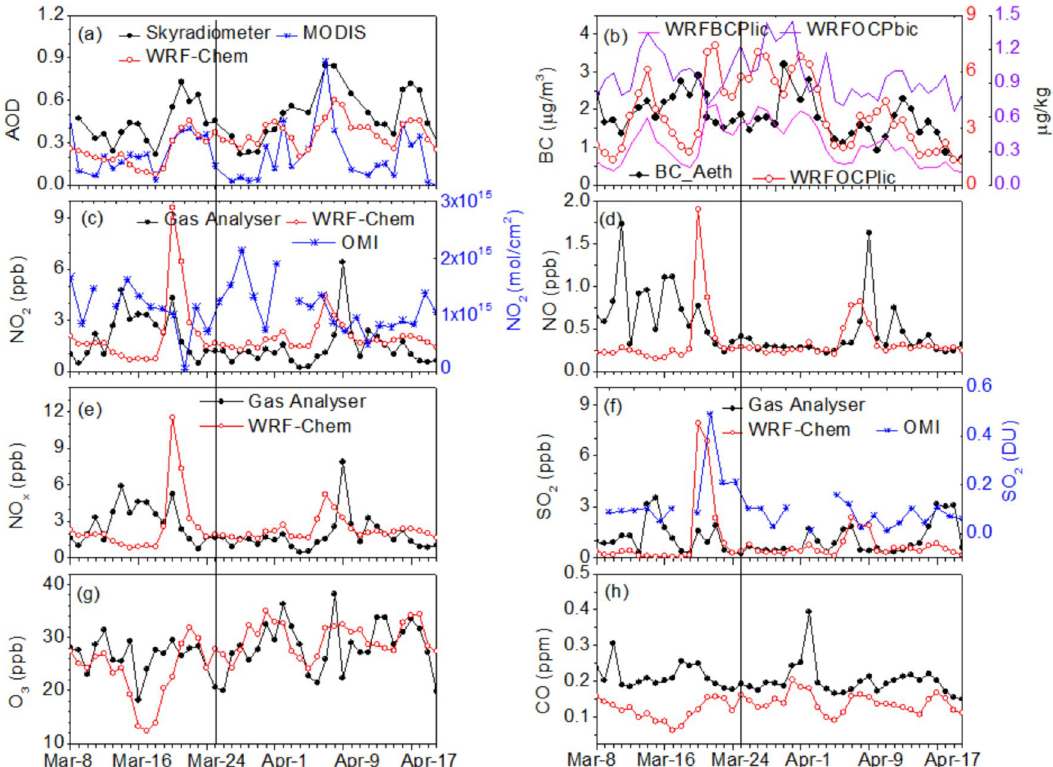
Figure 1. Time series for ( a ) AOD, ( b ) BC, ( c ) NO 2 , ( d ) NO, ( e ) NO x , ( f ) SO 2 , ( g ) O 3 , and ( h ) CO obtained from WRF-Chem model simulations for March 8 to April 20, 2020 over the Gadanki region. Trace gases obtained from a gas analyser at Gadanki are superimposed on the respective panels ( c – h ). Skyradiometer AOD and Aethalometer BC are also superimposed in ( a ) and ( b ), respectively. Hydrophilic and hydrophobic BC and OC as simulated by WRF-Chem are also shown in ( a ). MODIS AOD is superimposed in ( a ). NO 2 and SO 2 from OMI are superimposed in ( c ) and ( f ), respectively. Note that model simulated O 3 and CO are doubled and halved, respectively. WRF-Chem simulated outputs are represented by red lines, ground-based observations by black lines, and satellite observations by blue lines. The vertical line indicates the date on which the lockdown began. The figures are plotted using ORIGIN software (https:// www. origi nlab. 2020 at 71 locations, varied between 0.4 and 0.8 (at 95% confidence level) except very few locations (Fig. 2). A correlation coefficient of about ~ 0.7 is achieved at most of the locations and for all the pollutant concentrations except for O 3 (~ 0.3). The correlation for NO 2 and PM 2.5 are reach their maxima of about ~ 0.8 over northwest, central and south India. Note that we have configured the scale factor to reduce the emissions uniformly across India by 40% during lockdown in the WRF-Chem simulation even though spatial variations in the reduction of these pollutants was reported based on ground 45 and space borne measurements 44 . WRF-Chem simulated and the observed AODs at three AERosol RObotic NETwork (AERONET) stations, Gandhi College, Kanpur and Lahore, also suggest good correlations (at 95% confidence level) of about 0.67, 0,62 and 0.54, respectively (Figure S2). We further computed the correlation coefficients at each grid point between observed tropospheric mean NO 2 and SO figure. In general, the WRF-Chem simulated AOD, NO 2 and SO 2 over the Indian region are significantly (at 95% confidence level) correlated with the satellite measurements. The WRF-Chem simulated NO 2 and OMI derived NO 2 exhibit reasonably good correlation (about ~ 0.6) over the Indian continent except over central India and the IGP region. The correlation values for SO 2 are close to ~ 0.6 over the central and northwest parts of India. Similarly, WRF-Chem simulated and MODIS derived AOD also show a very good correlation of about ~ 0.8 over the entire Indian region. This gives further confidence that WRF-Chem is able to capture the variability of these pollutants reasonably well when compared to the ground and satellite-based measurements. The spatial distribution of the AOD and trace gases (NO 2 and SO 2 ) predicted by WRF-Chem are compared with the satellite measurements in Figure S4. The composite mean of instantaneous values of AOD from swath data of MODIS and corresponding values of WRF-Chem obtained during March 8 and April 20, 2020 (Fig. S4a,b) indicate almost similar spatial distributions as those MODIS AOD over Central India, the IGP, and Northeast India, with lower values over Northwest India. The tropospheric mean NO 2 and SO 2 concentrations in the plan- etary boundary layer derived from the OMI (Fig. S4c,e) and the model (Fig. S4d,f) between March 8 and April 20, 2020 suggests that the NO 2 and SO 2 hotspots of slightly different magnitudes over Central and Northeast